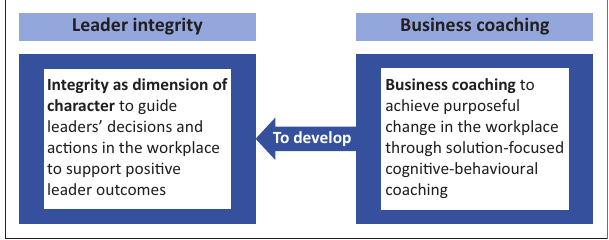
FIG URE 1: Theoretical perspectives underpinning this